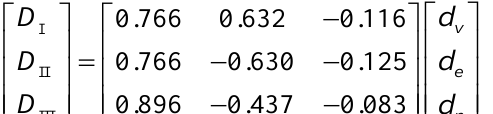
Table 1, the transform Equation (11) for the LS solution can be rewritten by: I